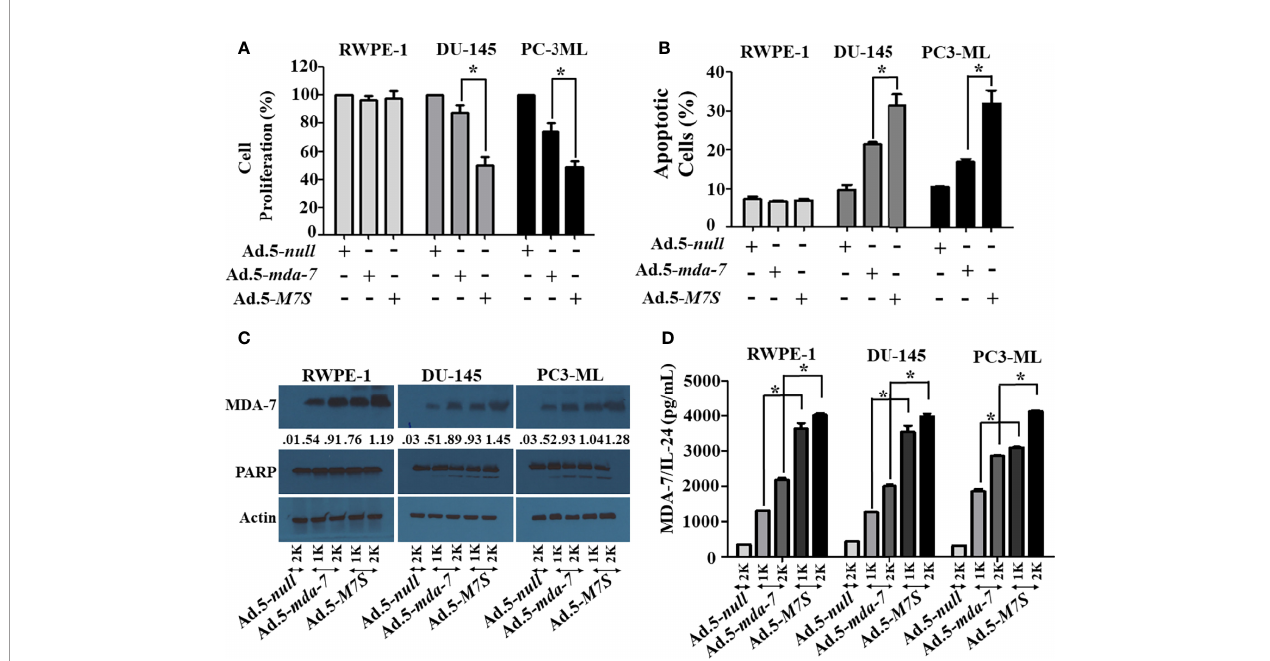
FIGURE 3 | Ad.5- M7S suppresses proliferation and induces apoptosis of prostate cancer cells more robustly than wild type Ad.5- mda-7. (A, B) . Different prostate cancer cells (DU-145 and PC3-ML), and immortal primary prostate epithelial cells (RWPE-1) were infected with Ads expressing either mda-7/IL-24 or M7S ( IL-24S ) at different m.o.i. After 72 hr., cell proliferation (A) and apoptosis (B) were determined by MTT assay and Flow-cytometry (Annexin-V/PI- staining), respectively. (C) Western blotting analysis was performed to determine intracellular MDA-7/IL-24 protein levels and PARP cleavage. Actin was used as a loading control. Values underneath the blot represent fold-changes in densitometry for MDA-7/IL-24 protein levels using actin as a control. (D) Secretion of MDA-7/IL-24 was determined in infected cell-derived CM using MDA-7/IL-24-speci fi c ELISA. *Statistical signi fi cance (p<0.05). Different virus dose indicated as viral particles (VP): 1K: 1000 VP; 2K: 2000